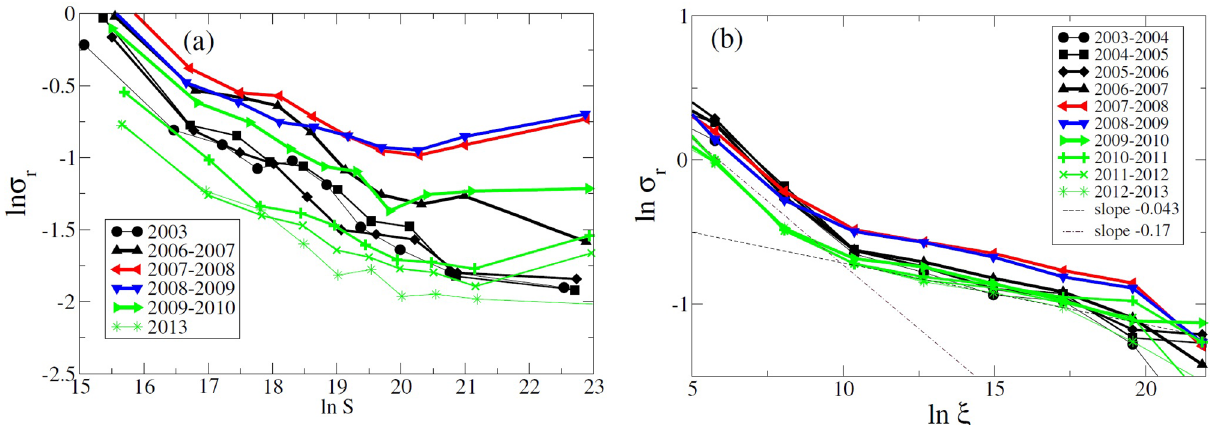
Figure 1. Size-Variance Relationship Log–log plot. ( a ) shows the relationship between the logarithm of the size of the funds and the standard deviation of the growth rates for different time intervals. We divide the entire size distribution in 10 bins each containing the same number of observations. For each bin size, we compute all the growth rates of those funds whose initial market value belongs to that bin and use the standard deviation of the corresponding growth rates as the y coordinate on the plot. We also compute the average size of funds in each bin and use it as the x coordinate. Log–log plot ( b ) shows the same relationship for the market values of individual